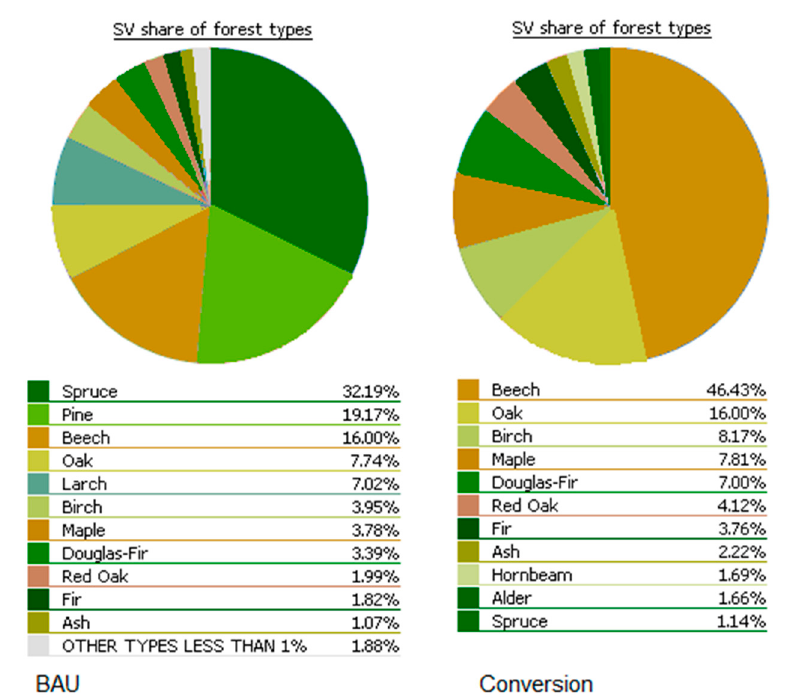
Figure 8. Contributions to standing volumes (SV) per tree species in time step zero for the business as usual scenario (BAU scenario 1, left) and forest conversion in scenarios 2 and